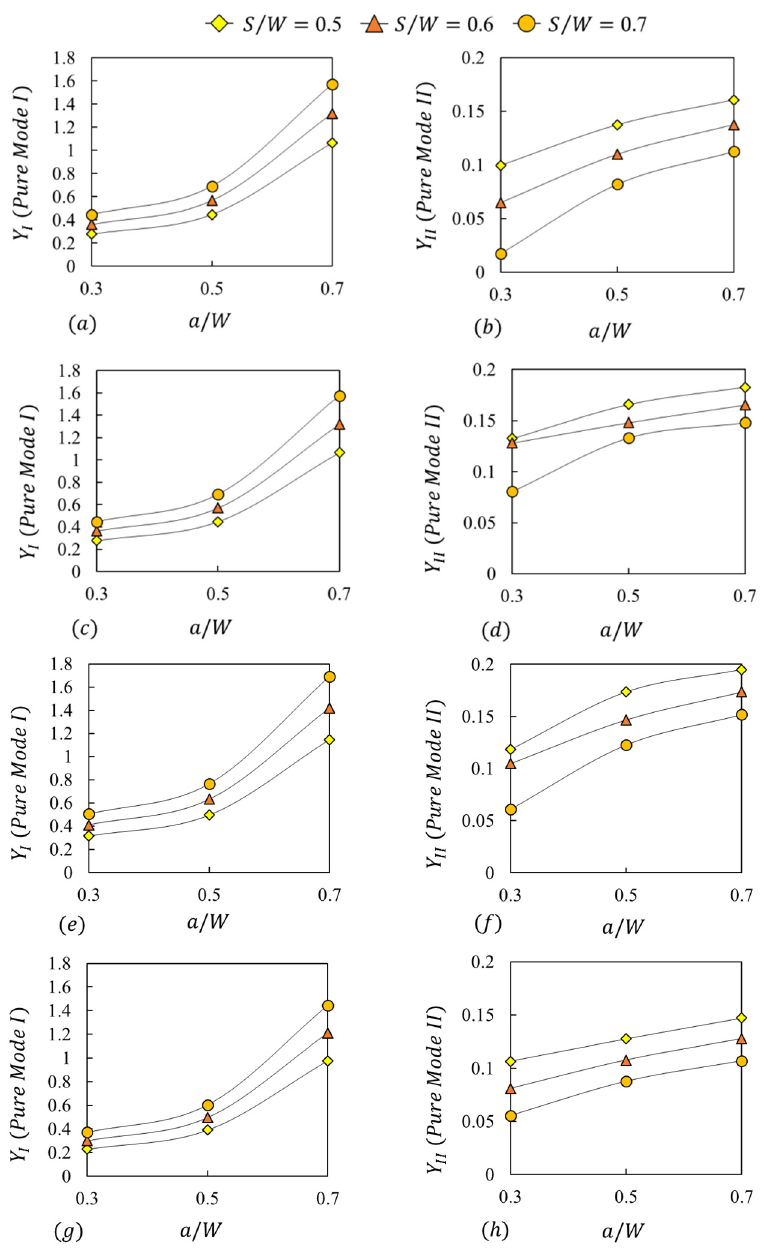
Figure 7. Corresponding values of pure mode I and pure mode II geometry factors for the analyzed specimens with different a/W and S/W ratios. ( a , b ) Al-Adhesive-Alumina, ( c , d ) Alumina-Adhesive- Al, ( e , f ) Al-Adhesive-Al, ( g , h ) Alumina-Adhesive-Alumina. The variations of non-dimensional T -stress ( T *) for different loading conditions and material groups of the analyzed BISBB samples are presented in Figure 8. As seen, the T - stress is significantly negative for mode I dominant conditions (i.e., smaller values of α ). Under such situations the value of T * is sensitive to the crack length ratio ( a/W ). However, by further increasing the crack angle and moving towards pure mode II loading condition, the sensitivity of T -stress to a/W becomes lesser and the corresponding value of T * tends to zero. The absolute value of T * increases in the BISBB specimen by increasing the crack